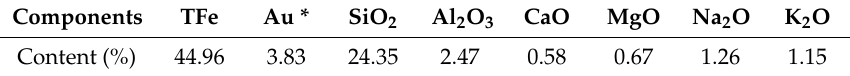
Table 1. Main chemical composition of received cyanide tailings.